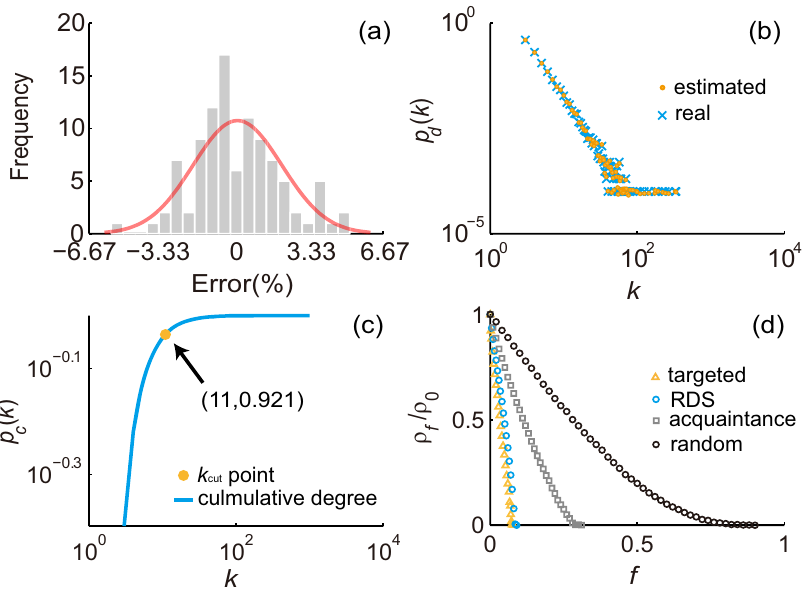
Figure 2. Basic results of BA network. ( a ) The error distribution of estimated average degree. ( b ) The average of estimated degree distributions and the real degree distribution. ( c ) The cumulative degree distribution obtained from the estimated degree distribution of one simulation. In this simulation, the value of k cut is 11. ( d ) Reduced prevalence ρ f / ρ 0 from simulations of the SIS model on the BA network with random strategy, acquaintance strategy, targeted strategy and RDS strategy, at a fixed spreading rate λ = 0.25. The prevalence is averaged over 100